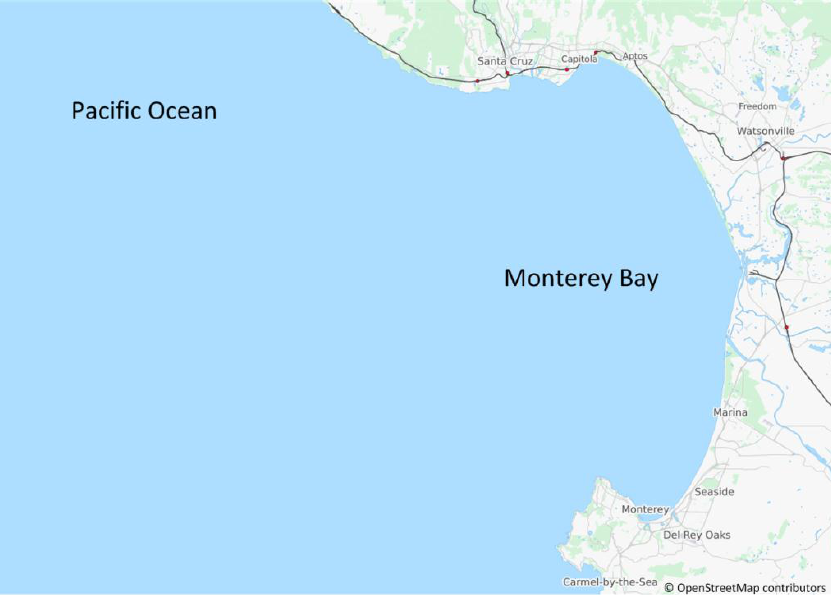
Figure 1. Overview of the study region. Monterey Bay